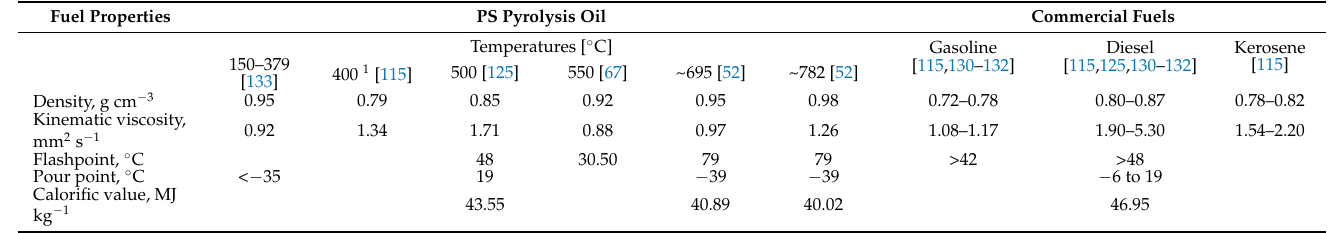
Table 3. Summary of fuel properties from PS pyrolysis and commercial